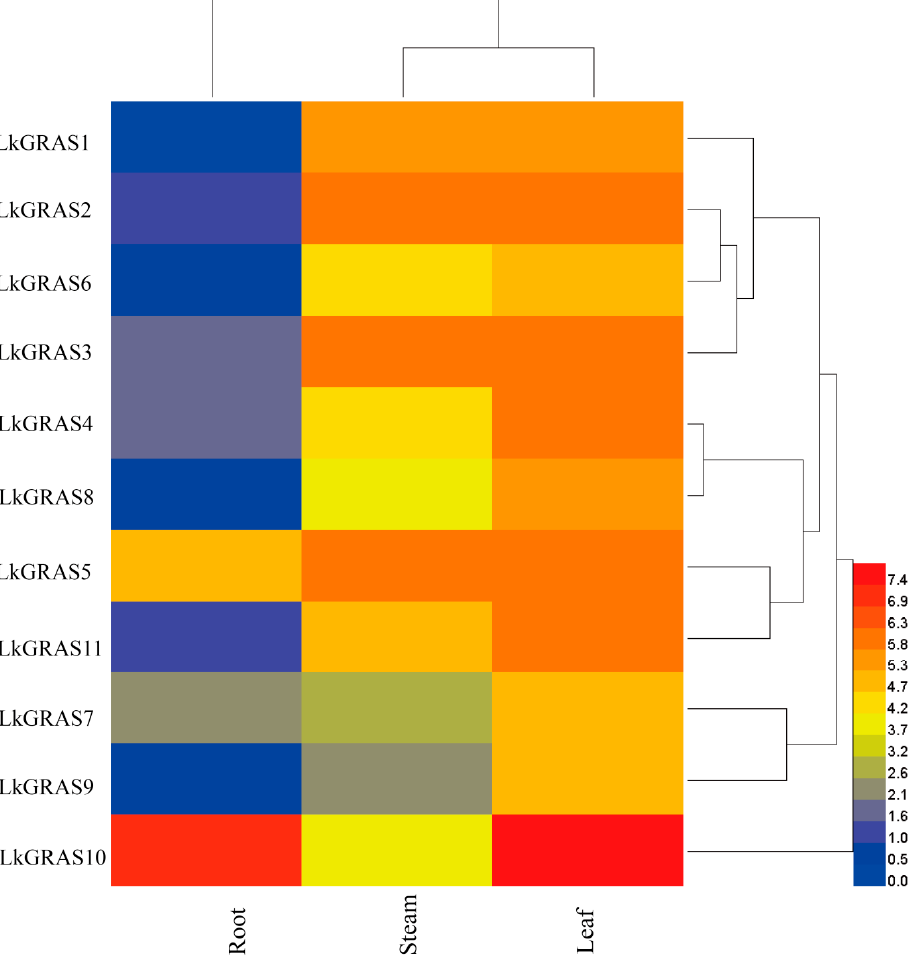
Figure 4. Tissue-specific expression pattern of LkGRAS genes. The relative gene expression levels were calculated using the 2 − ∆∆ Ct method. Different colors represent different expression levels: blue, green, and red colors represent low, mild, and high expression levels,